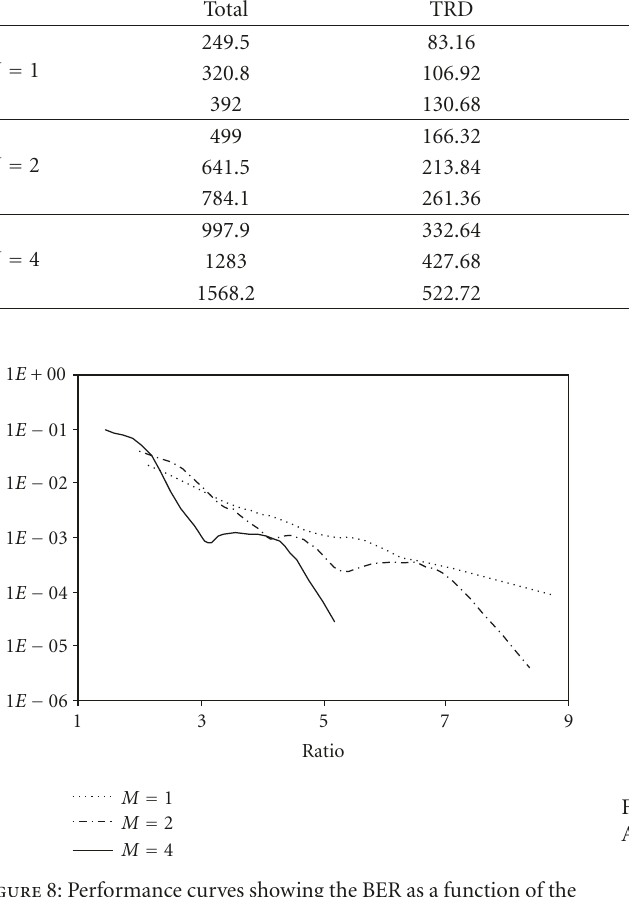
Figure 8: Performance curves showing the BER as a function of the ratio in (30) for M = 1,2, and 4.